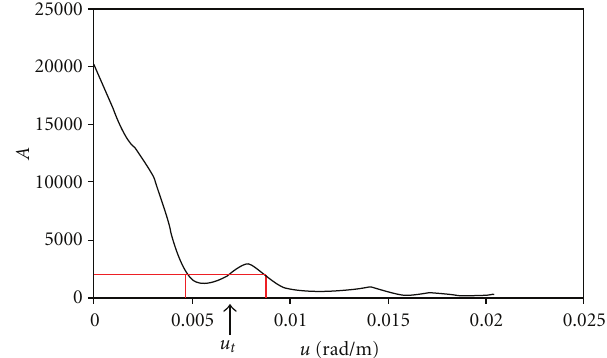
Figure 10: The amplitude spectrum of the SP anomaly.